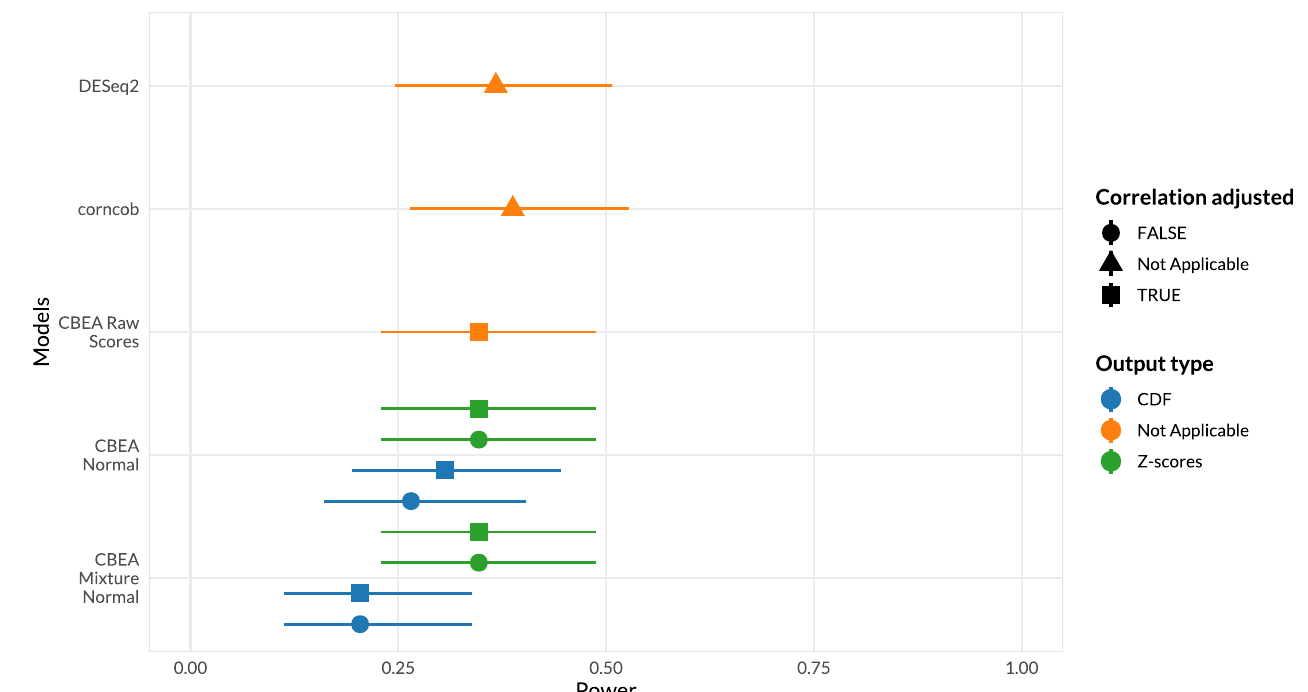
Fig 5. Statistical power to assess phenotype relevance of inference tasks at the population level. Power ( x -axis) was estimated as the overall fraction of sets representing genera that are aerobic or anaerobic microbes found to be differentially enriched across sample type (supragingival or subgingival). 95% confidence intervals were computed using the Agresti-Couli approach for binomial